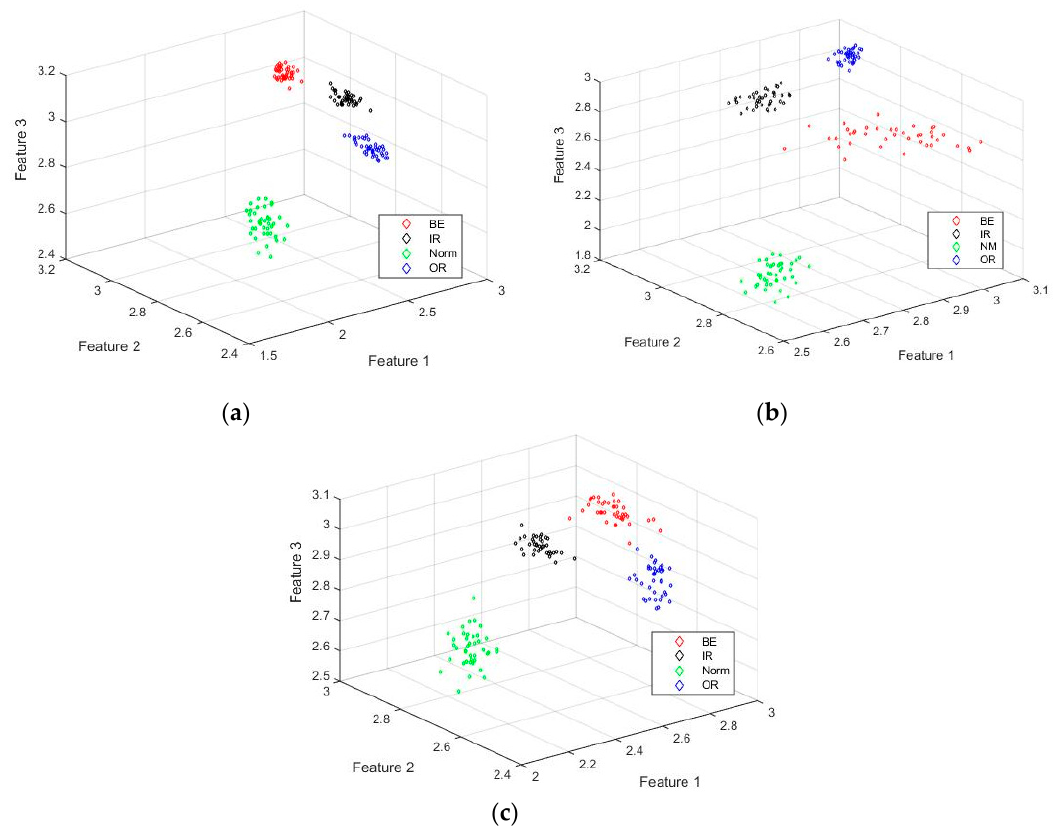
Figure 11. Three dimensions of the IMAAPE feature vectors for different fault types under different fault diameters with the load 0 hp. ( a ) fault diameter is 7 mils; ( b ) fault diameter is 14 mils; ( c ) fault diameter is 21 mils.